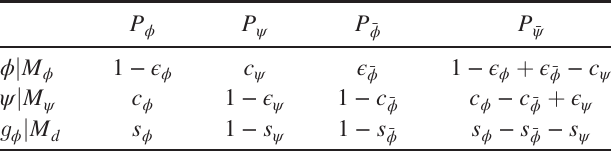
TABLE III. Data table for our operational scenario with no symmetries assumed. There are nine free